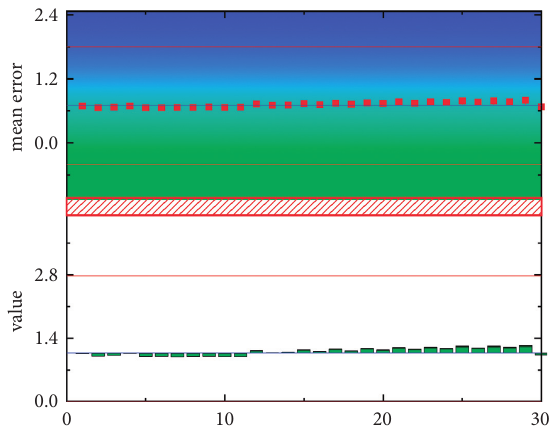
Figure 6: The mean and minimum value of the predicted value of the company’s financial risk level over time.